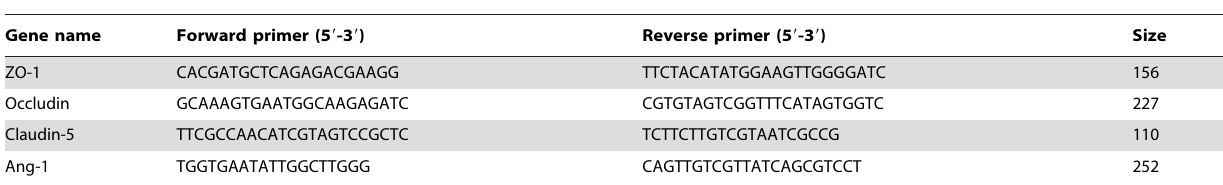
Table 1. Sequences of